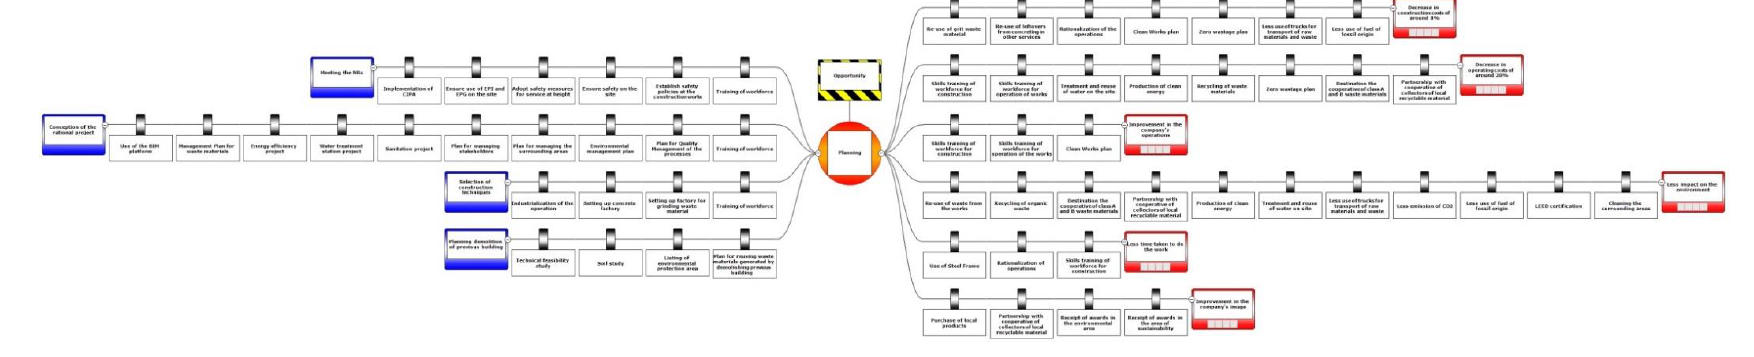
Figure A3. Bow-tie diagram for the activity of planning.